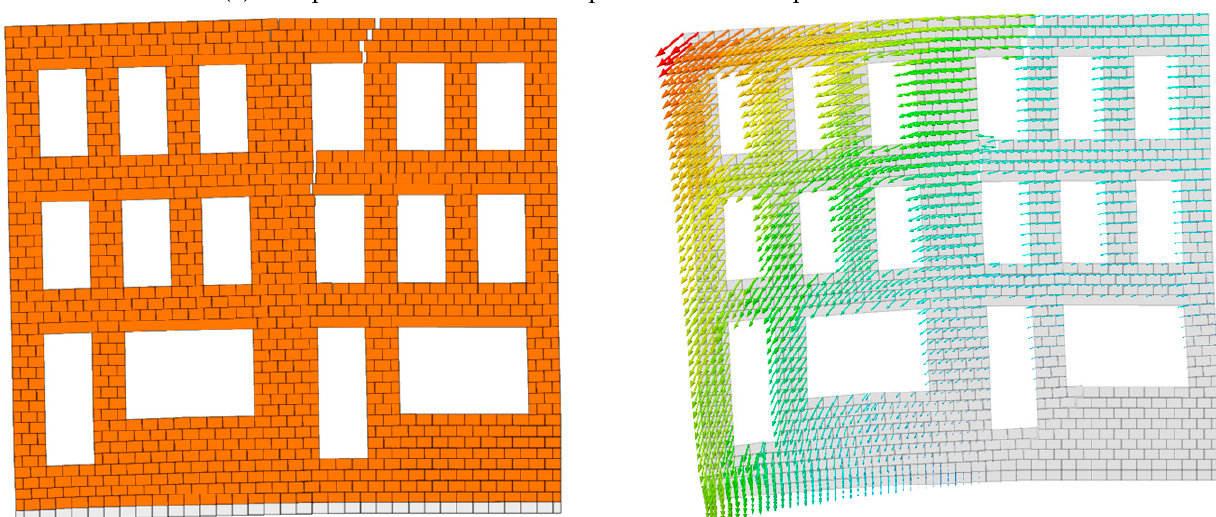
Figure 4. Predicted structural behavior and related displacement histories of D ‐ RBA compared to reference study.